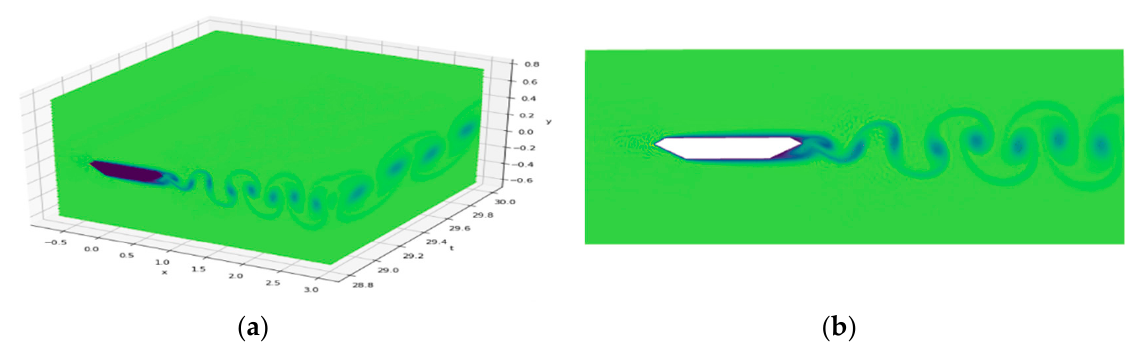
Figure 5. Training data for Re = 5000: ( a ) Concentration fi eld for Re = 5000 at T = 28.8–30; ( b ) Con- centration fi eld for Re = 5000 at T = 28.8.